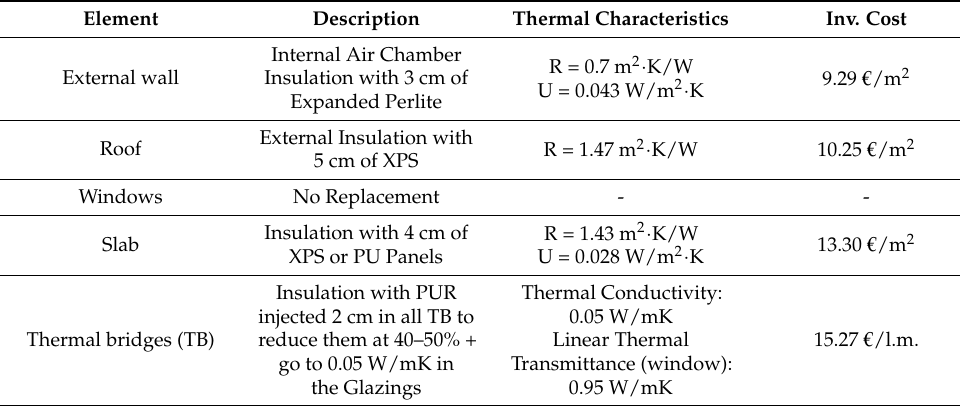
Table A5. POS5s: Renovation measures of solution